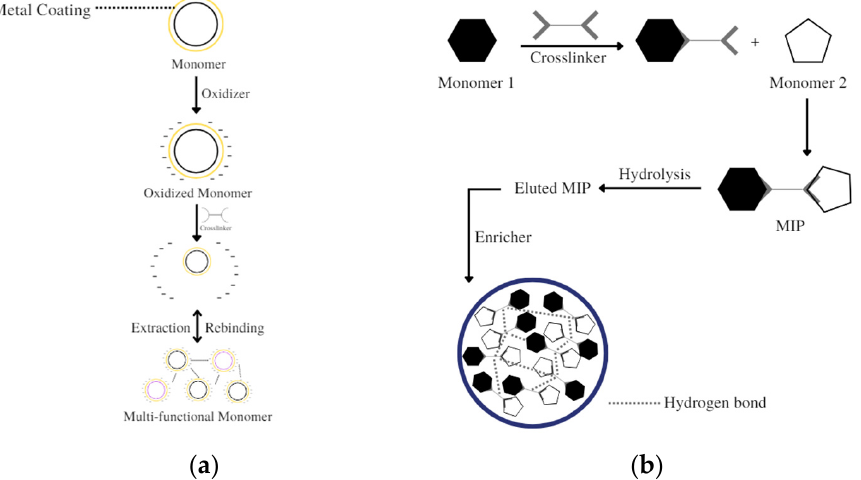
Figure 3. ( a ) Illustration of surface imprinting/electro − polymerization. ( b ) Illustration of emulsion polymerization.